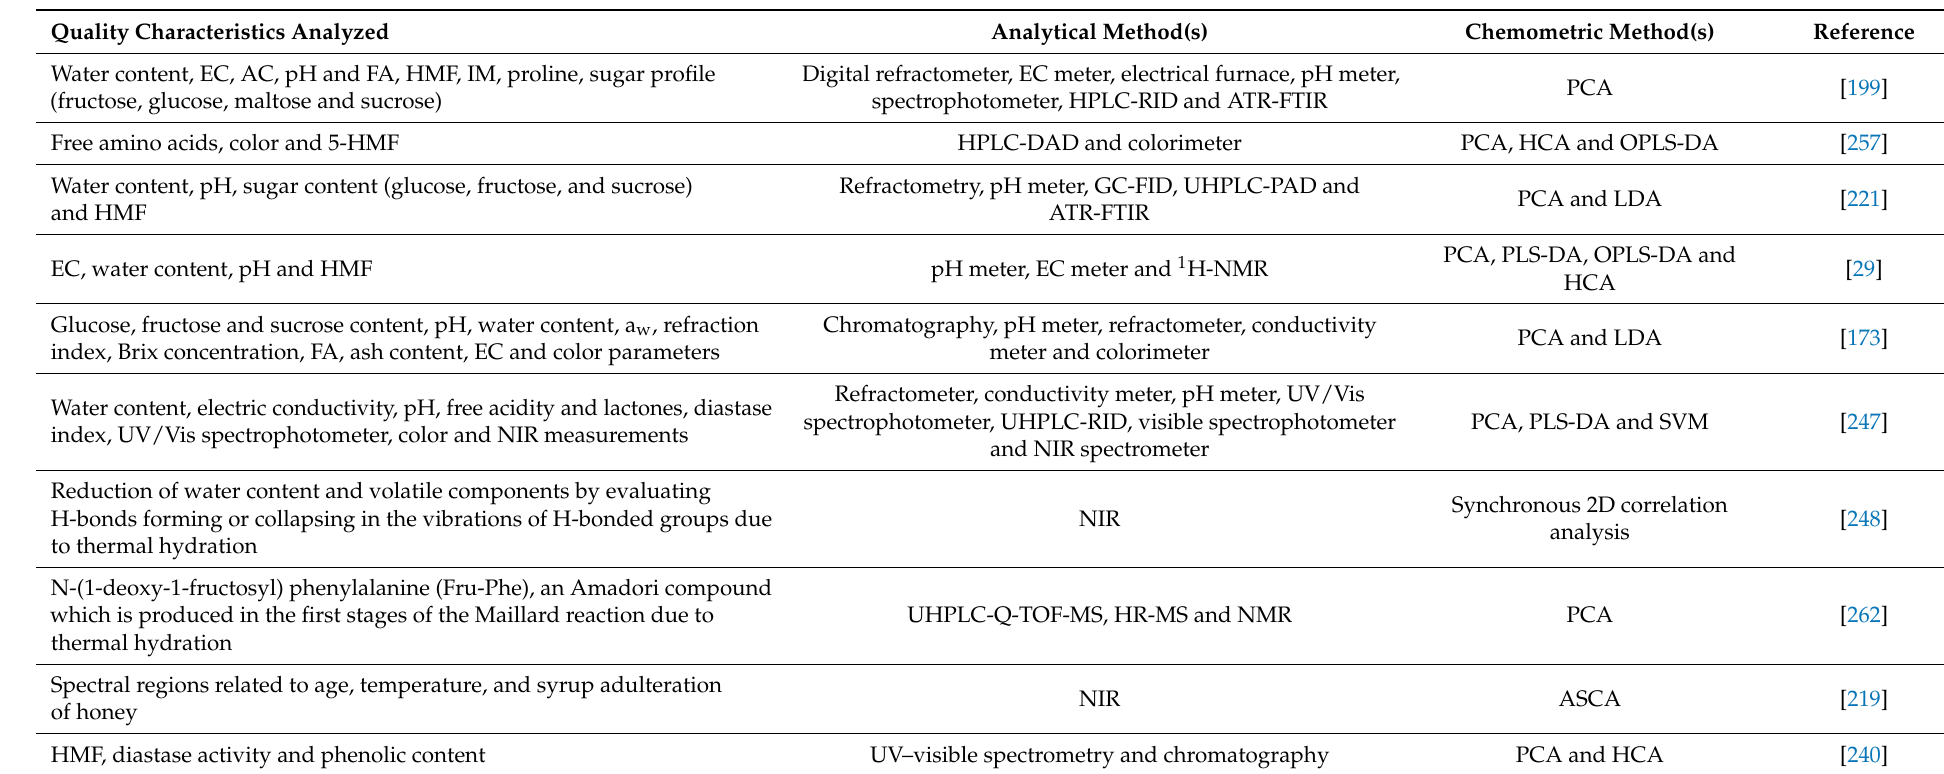
Table 3. Research studies related to quality characteristics in honey during processing and